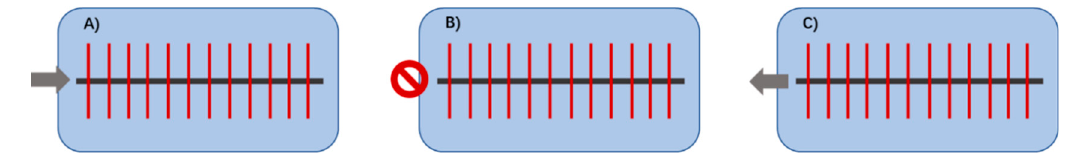
Scenarios of CO 2 Hu ff -n-Pu ff process. ( A ) CO 2 injection; ( B ) Soaking period; ( C ) Back production.